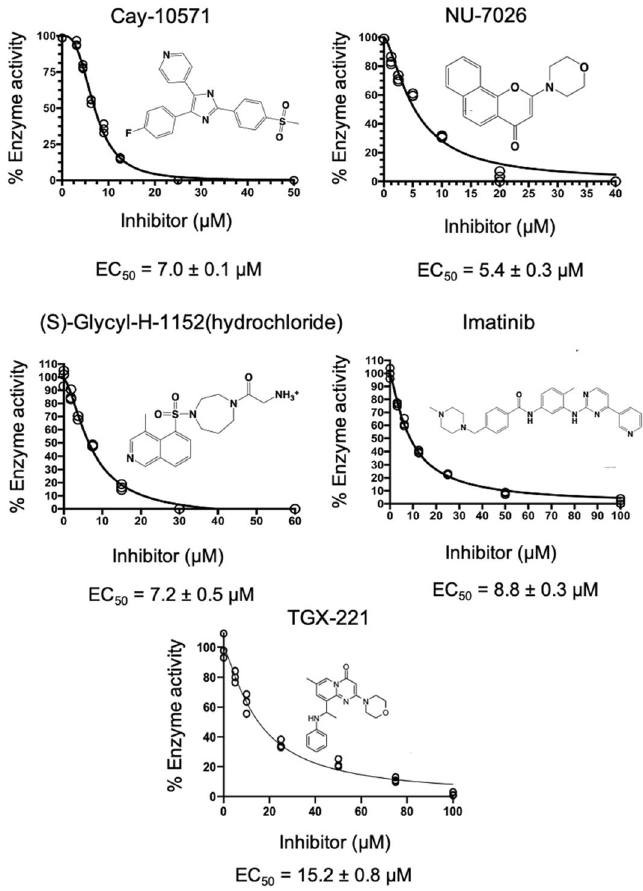
Figure 5. Dose–response curves for novel EgtD inhibitors. The figure shows the dose–response curves and calculated EC 50 values for each inhibitor. The calculated EC 50 values for the compounds are denoted below each plot.